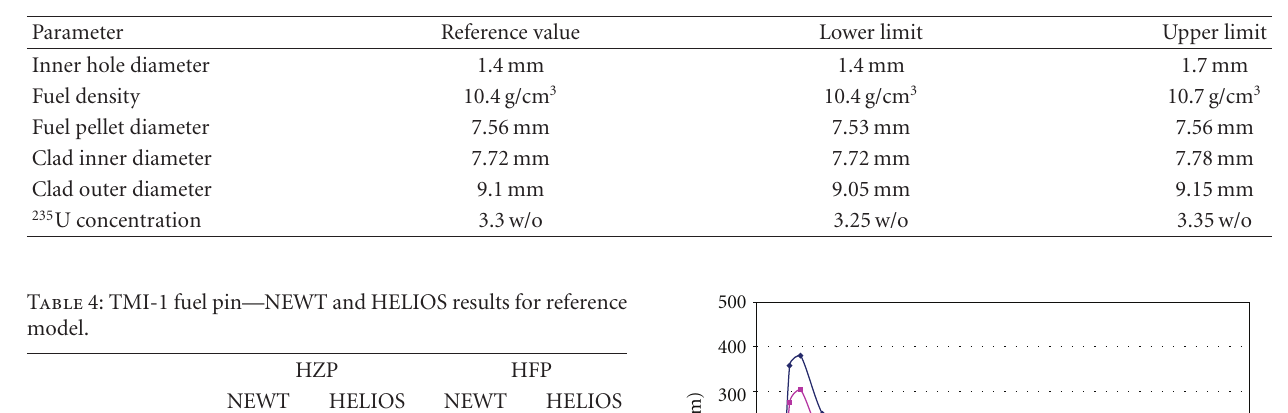
Table 3: Manufacturing tolerances for Kozloduy-6 test case.